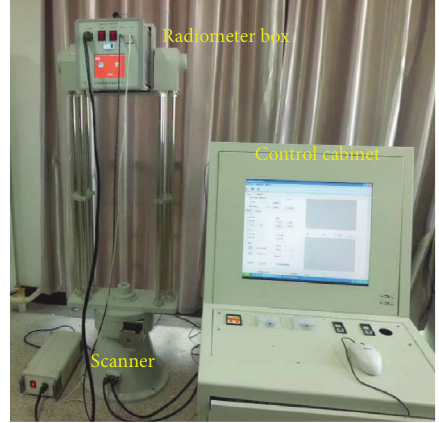
Figure 2: A picture of the W-band radiometer system.